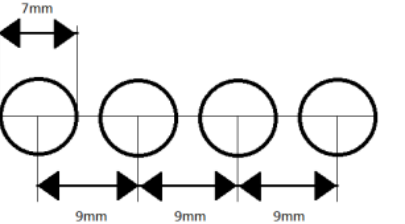
Figure 4. Schematic layout of the holes for electrodes in the acrylic glass.